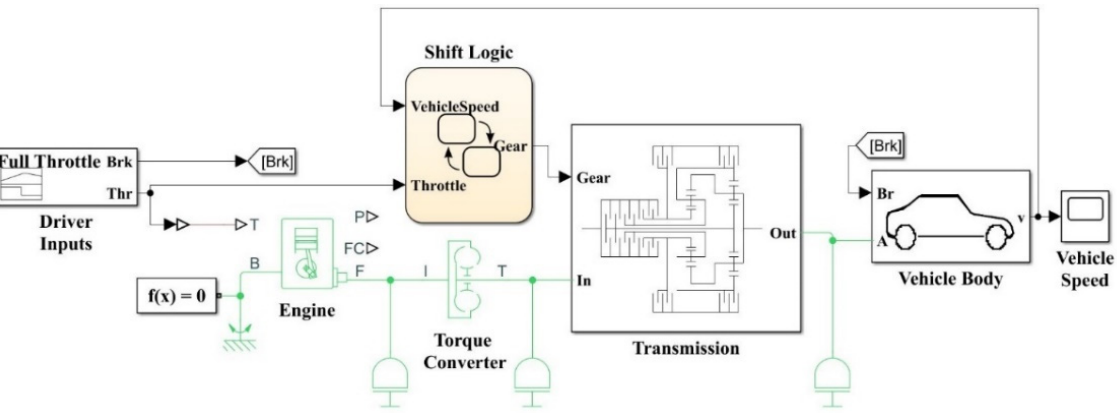
Figure 1. Simulation model of autonomous vehicle [22].